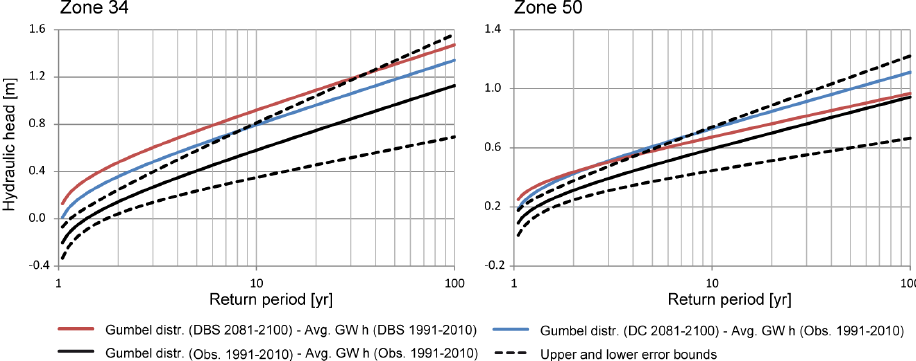
Fig. 9. Gumbel distributions for zone 34 and 50 based on observations for the baseline period (1991–2010) and upper and lower error bounds (black line and dashed black lines). Red and blue lines are the same as in Fig. 8 for the two zones.